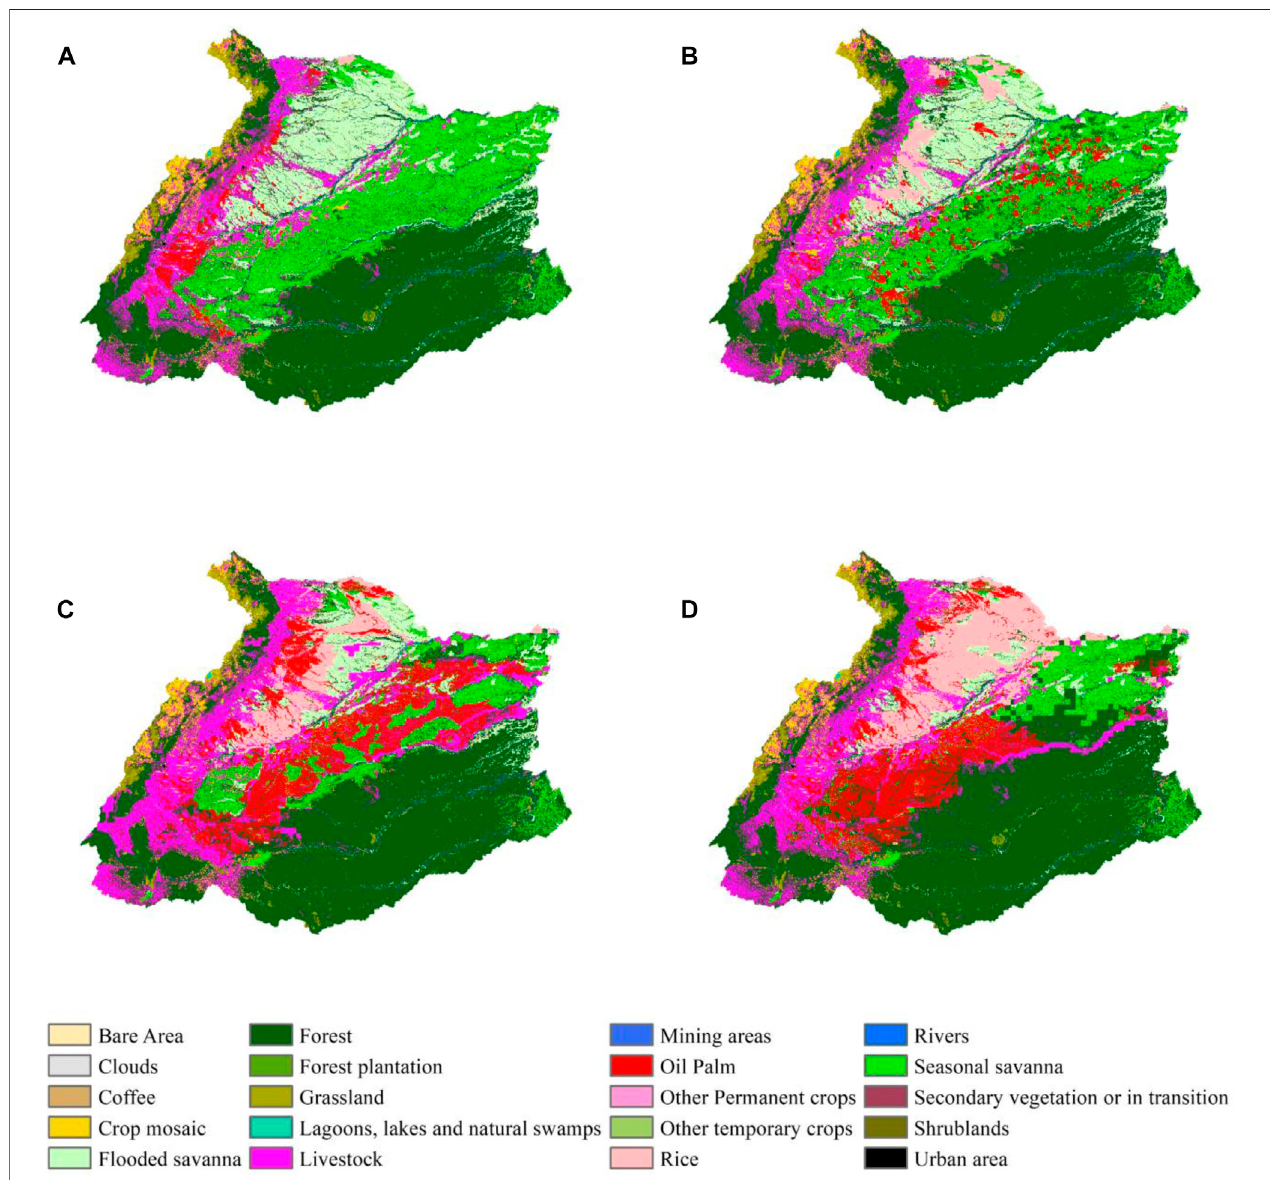
FIGURE6| Landusetransformation scenarios (A) Scenario1, (B) Scenario 2, (C) Scenario three andC) Scenario 4. Derivedfrom Williams et al.,2020.Calibration (A)showstheaveragerainfalloftheHAUuntilclosurewithstation 35107030(B)showsthecomparison oftimeseriesofobserved fl ow(blue)andsimulated fl ow(orange) and (C) shows the comparative scatter plot in the observed fl ow and simulated fl ow. Validation (A) shows the average rainfall of the HAU until closure with station 35107030(B)shows the comparison oftime series ofobserved fl ow(blue)and simulated fl ow(orange)and (C) shows thecomparative scatter plot in theobserved fl ow and simulated fl